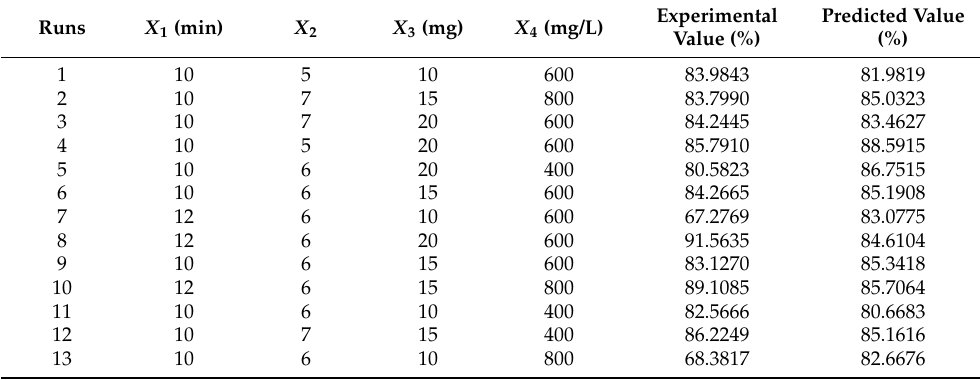
Table 5. The experimental design matrix of the backpropagation (BP) artificial neural network (ANN) model.